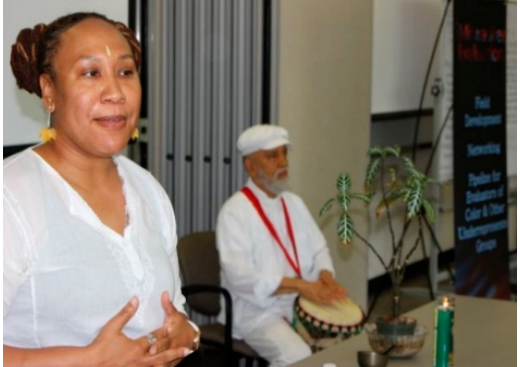
Figure 1. Photo of local healer Tavita Martinez (Mudwymn) training evaluators in warriorship (Photo Credit: Ishmael Robinson).